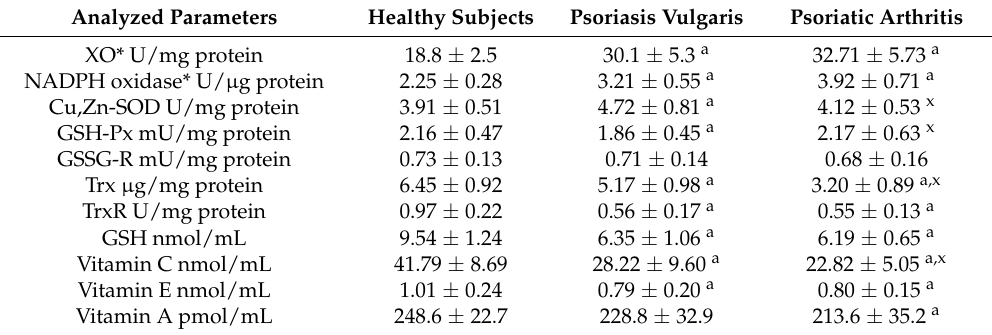
Table 1. The levels of oxidant and antioxidant parameters in plasma or granulocytes* from healthy subjects (n = 34) and patients with psoriasis vulgaris (n = 68) and psoriatic arthritis (n = 34).